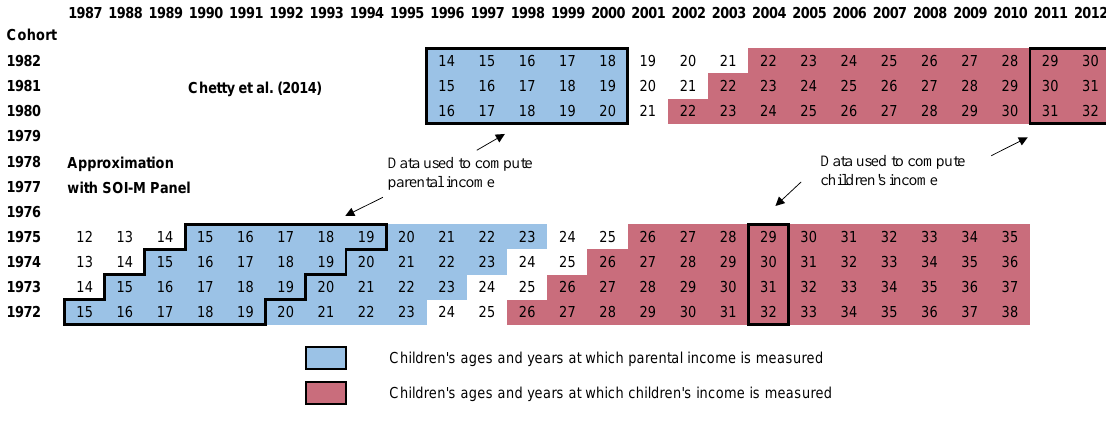
Figure 4: Chetty et al.’s (2014) children’s ages and parental-income measure approximated with data from the SOI-M